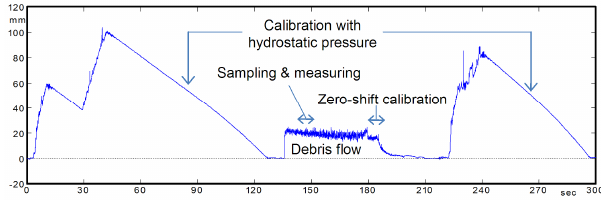
Fig. 2 Measurement system. Although several Fig. 3. Operation throughout an experiment. measurement surfaces are shown in the figure, Fig. 5. Time series of flow depth and interstitial water pressure for a only the measurement surface at the bed height particle diameter of 1.3mm, channel slope of 13 ◦ , and water supply was used. of 2ls − 1